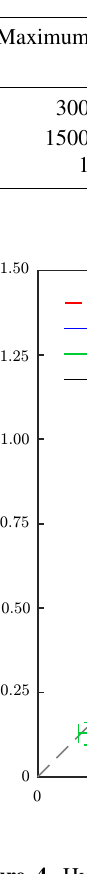
Figure 4. Hygroscopicity, κ noCC , plotted against κ nv . The grey dashed line shows equality between the axes, error bars showing the middle 67% of our derived values and the intersections of the error bars depicting the means. Ammonium sulfate is shown in red with dashed error bars, sodium chloride is shown in blue, levoglucosan is shown in green and sulfuric acid is shown in